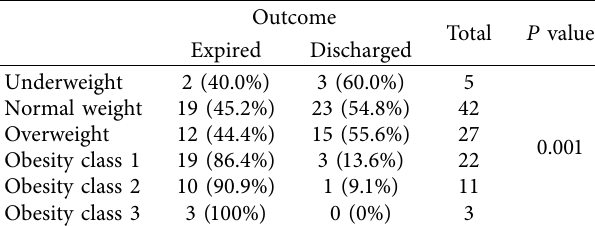
Table 2: Cross-tabulation of BMI categories and patients’ outcomes.